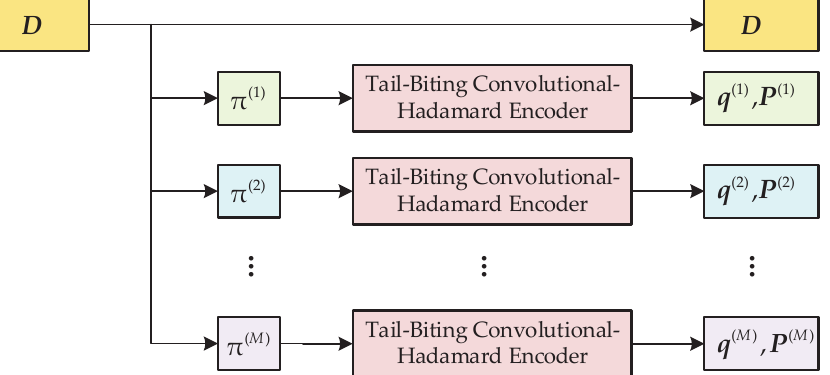
Figure 4. A tail-biting turbo-Hadamard encoder with M component convolutional-Hadamard encoders. { π ( m ) , m = 1,2,..., M } are interleavers corresponding to each component